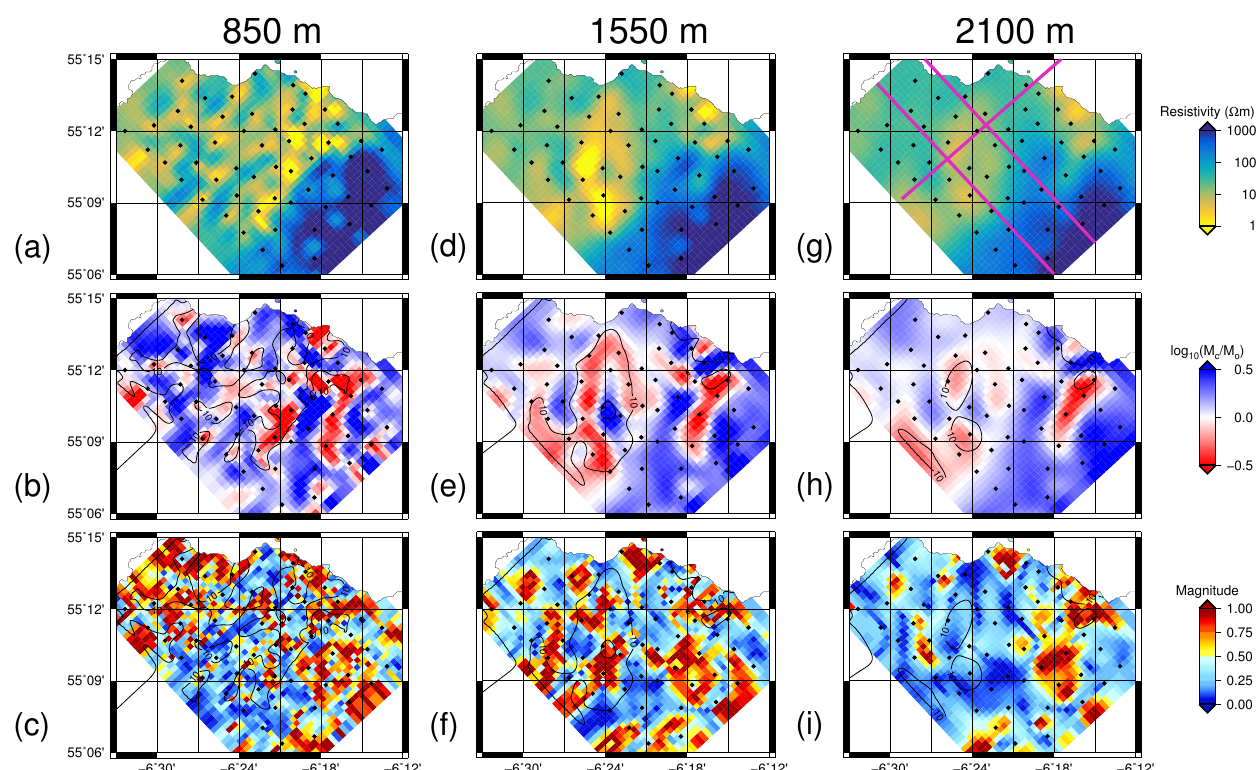
Figure 11. Top row shows resistivity slices through the static-shift-corrected model M c taken at 850 (a) , 1550 (d) , and 2100m (g) below sea level. Middle row shows the resistivity difference (cid:49) between the models in decades ( (cid:49)(M c ,M o ) = log 10 (M c /M o ) ) for the same depths, where red shows M c more conductive than M o and blue more resistive. Bottom row shows the magnitude of the normalised cross-gradient (the cross-product of the gradient vectors of each model ∇ M , as defined in Eq. 7), as a diagnostic of structural similarity between the models, with 0 (blue) showing parallel gradient vectors (i.e. very similar structure) and 1 (red) showing orthogonal gradient vectors and structural disagreement. Note that the difference and cross-gradient plots are overlain by the 10 (cid:127) m contour from the corresponding resistivity slice. Magenta lines in panel (g) indicate the location of Profiles A, B, and